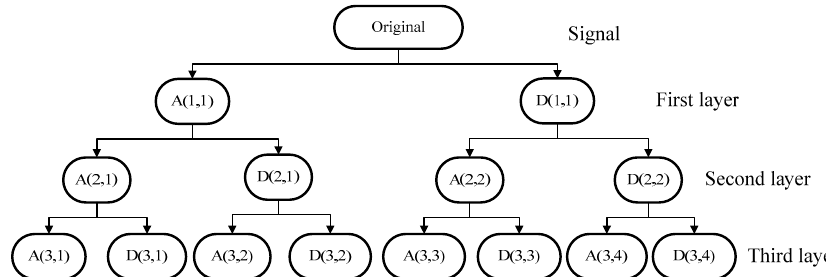
Figure 8. Three layers wavelet packet analysis. A ( i,j ) represents the j -th approximation coefficient in the i -th layer. D ( i,j ) is the j -th detail coefficient in the i -th layer.